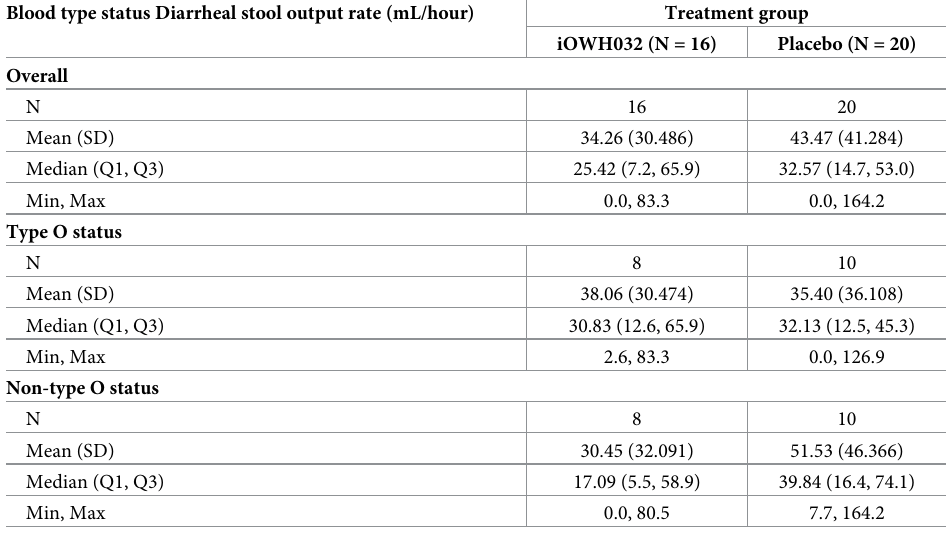
Table 4. Diarrheal stool output rate overall and by blood type status in the modified intent-to-treat population. Blood type status Diarrheal stool output rate